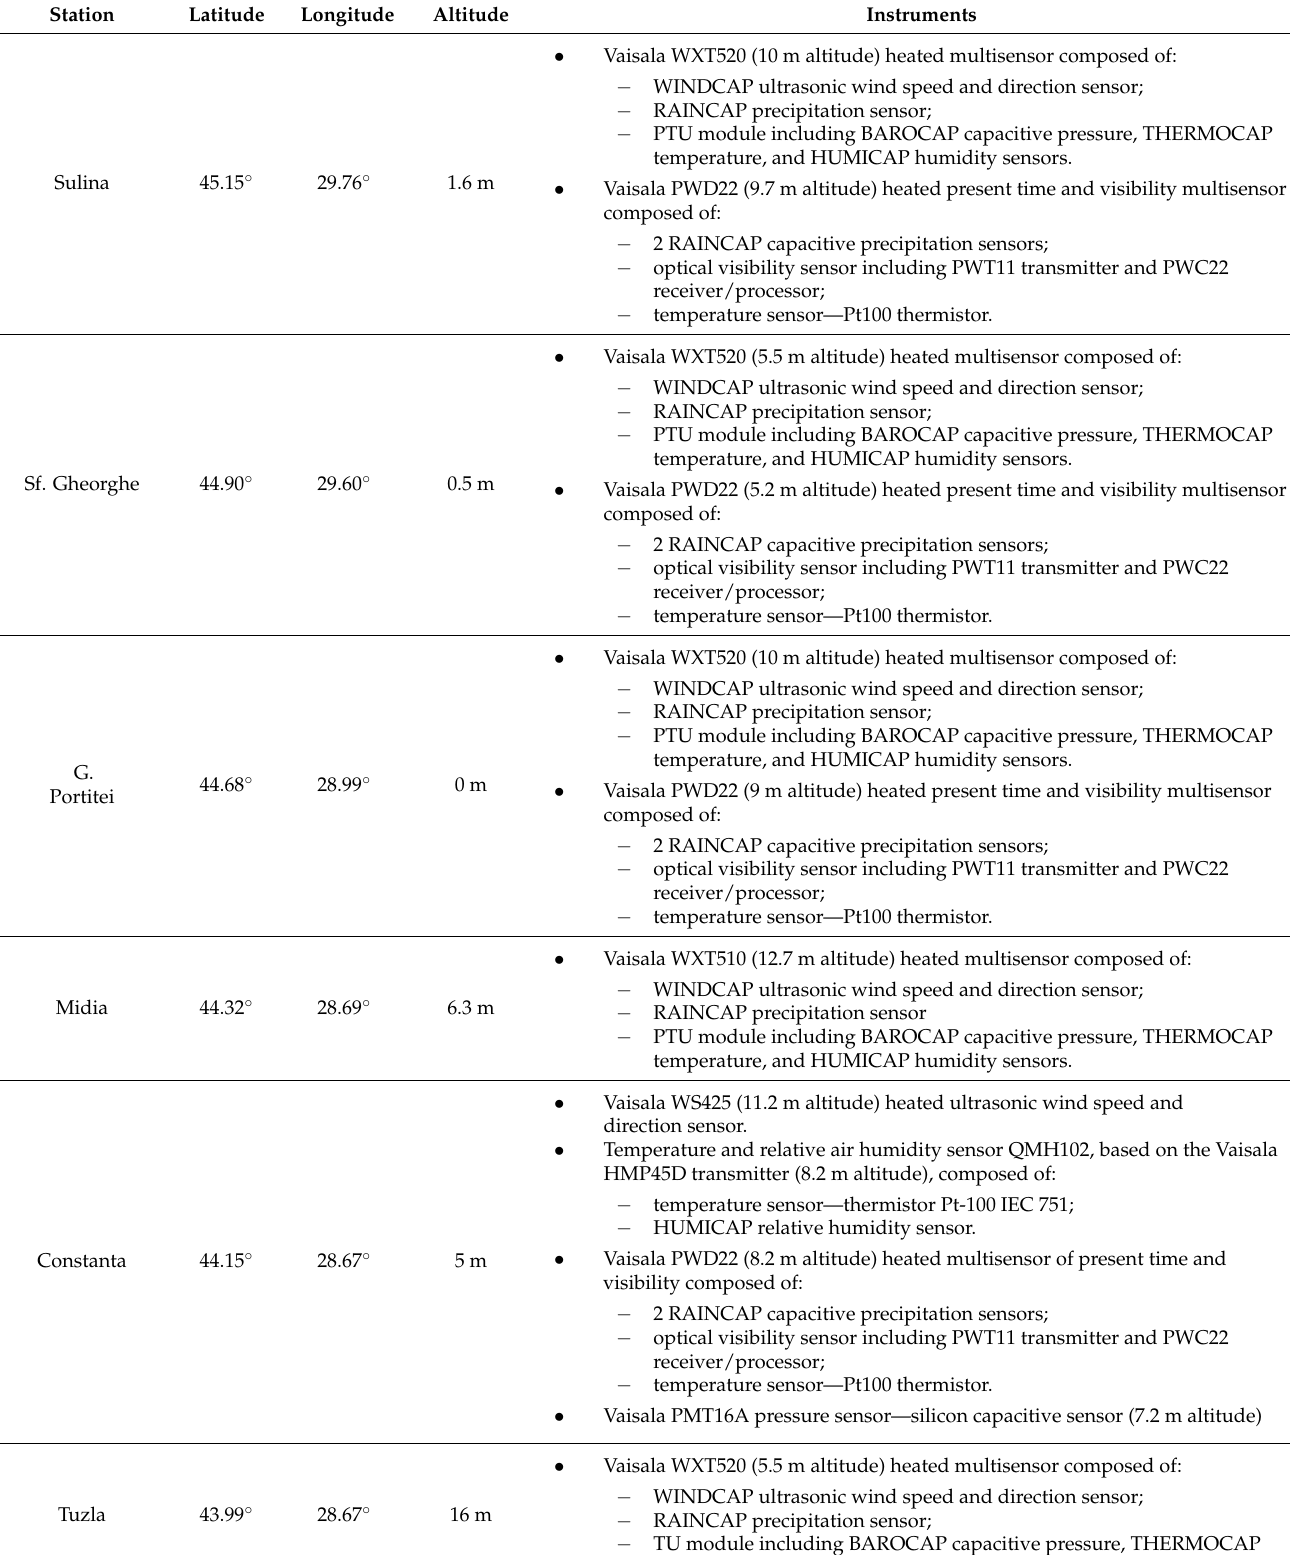
Table 1. Locations and characteristics of the seven automatic weather coastal